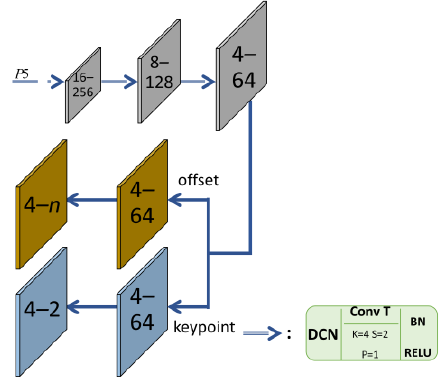
Figure 9. Keypoint head in Key-Yolact.